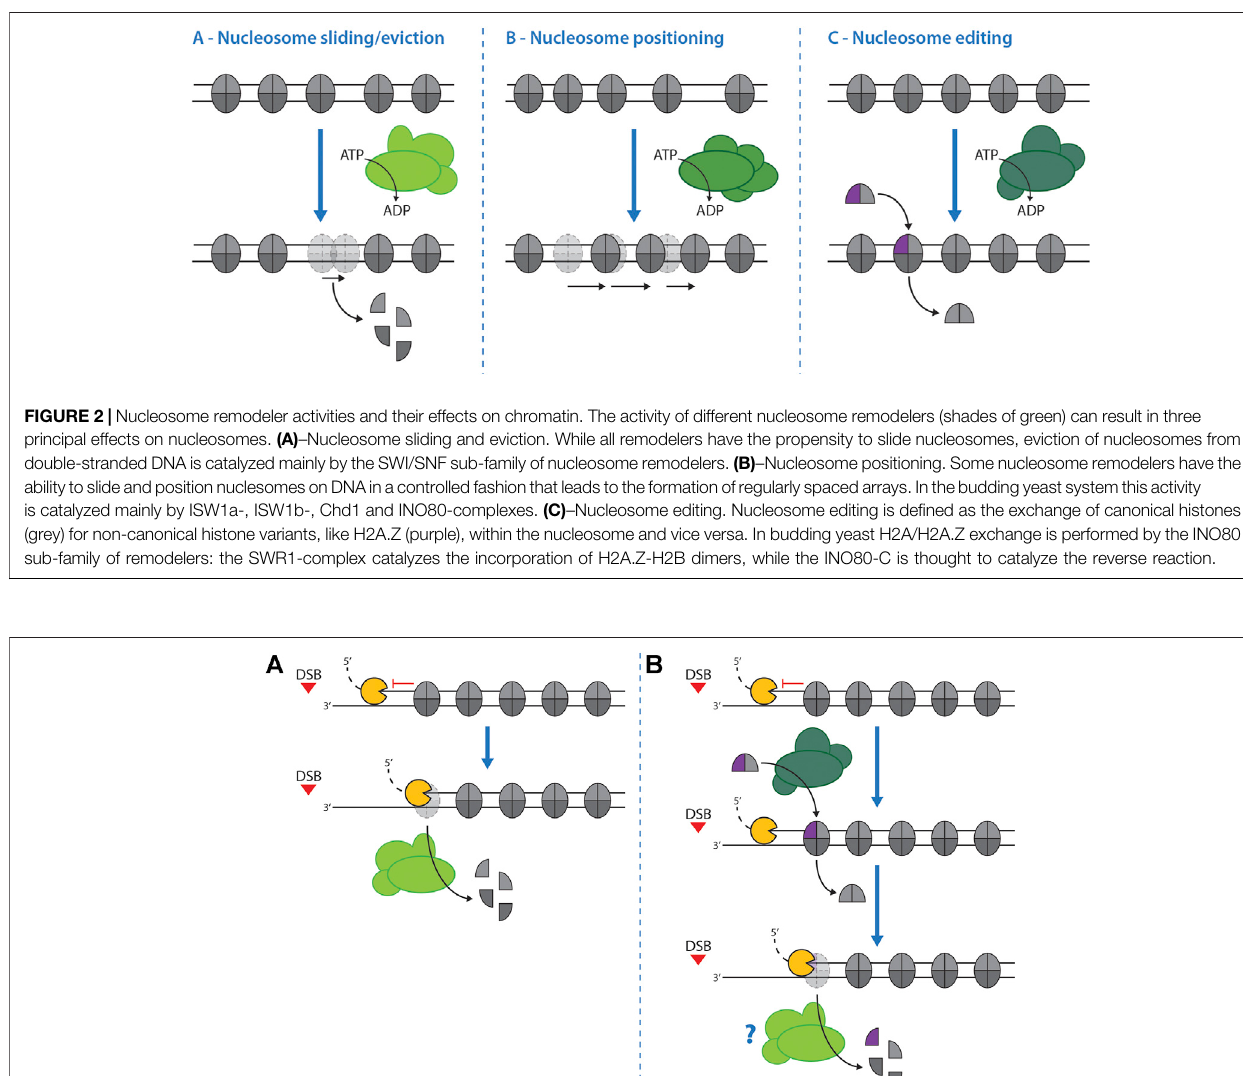
Frontiers in Genetics |